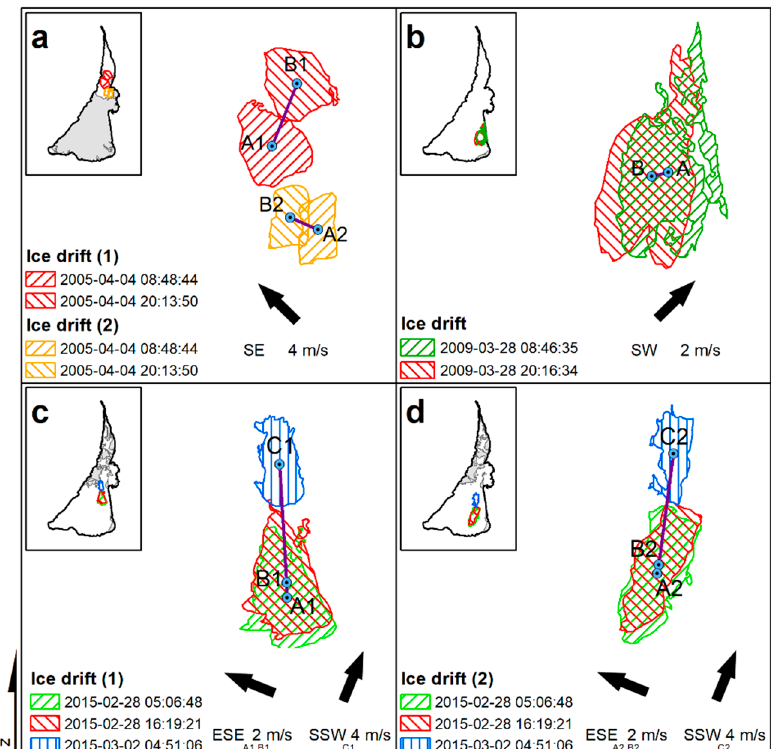
Figure 6. SAR-derived parameters of the ice drift in the Curonian Lagoon. ( a ) Drift of two ice floes observed on 4 April 2005; ( b ) drift of an ice floe on 28 March 2009; ( c ) drift of the first ice floe on 28 February and 2 March 2015; ( d ) drift of the second ice floe on 28 February and 2 March 2015. Labeled points indicate the polygon centroids, lines represent the linear distance between them, and the arrows indicate an average wind speed and direction.